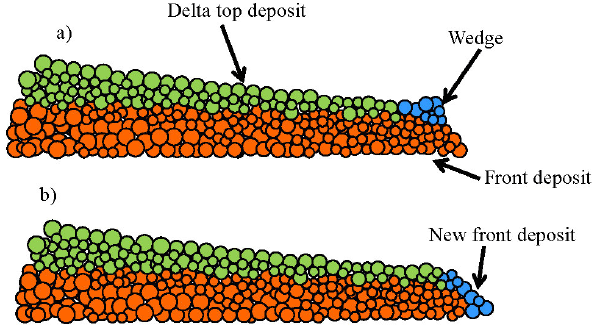
Figure 1. Schematic representation of the Gilbert delta